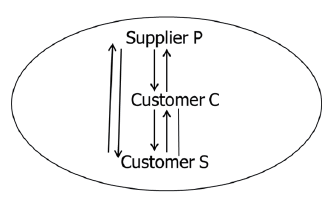
Fig. 3. – Customer C and its business network. Source: